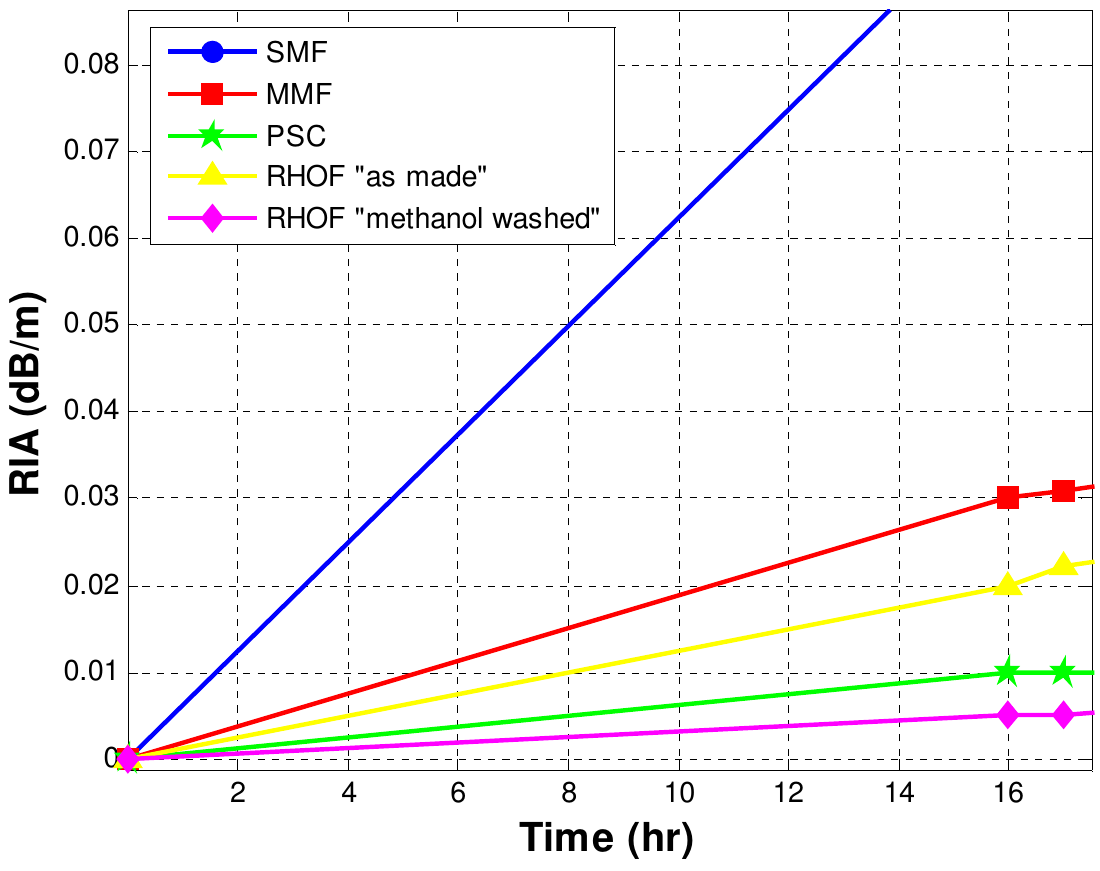
Figure 6. RIA of the sample fibers for the first 16 hours of irradiation showing the behavior of fibers under